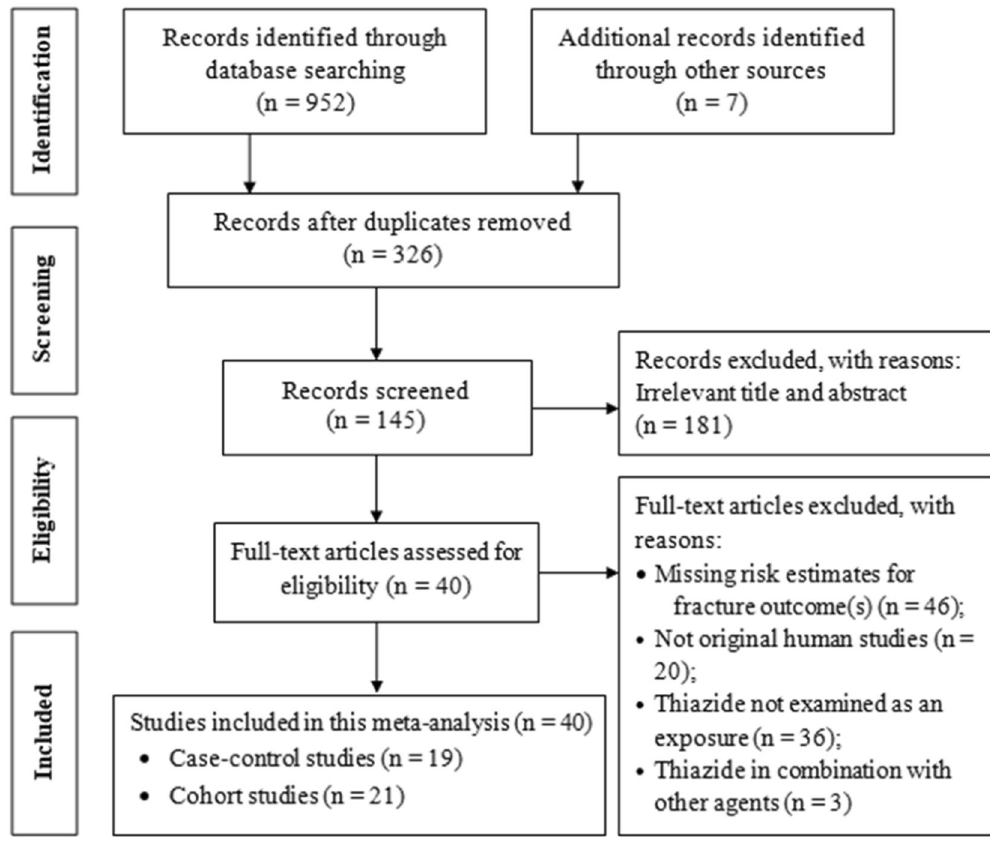
Figure 1. Flow chart for study inclusion and